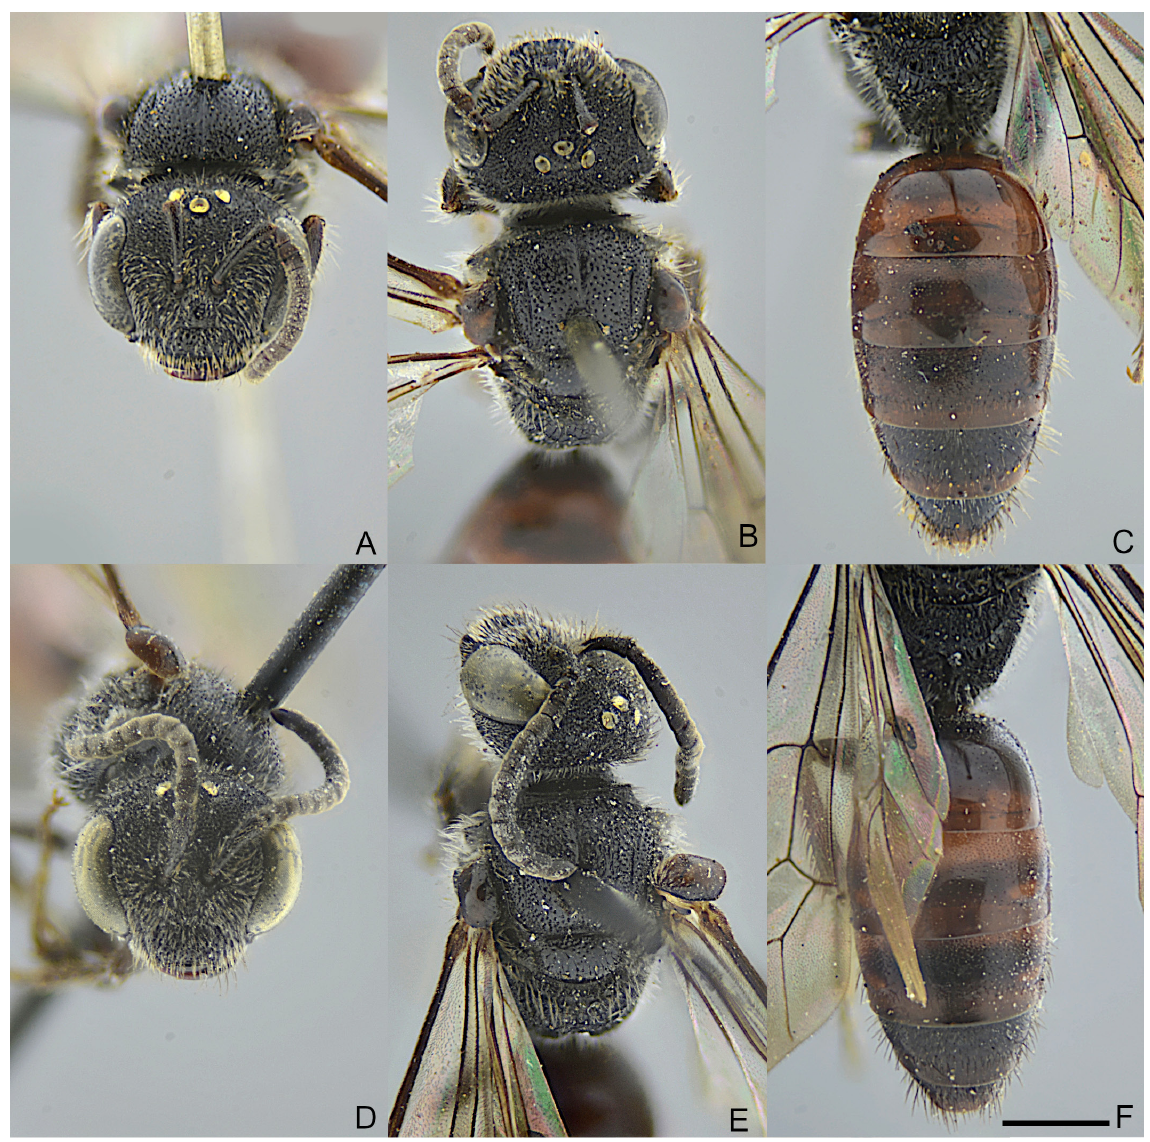
Fig. 4. Austrosphecodes gorgon sp. nov. A – C . Holotype, ♀ (DZUP 568520). D – F . Paratype, ♂ (DZUP 568521). A . Female head. B . Female mesosoma. C . Female propodeum and metasoma. D . Male head. E . Male mesosoma. F . Male propodeum and metasoma. Scale bar = 1